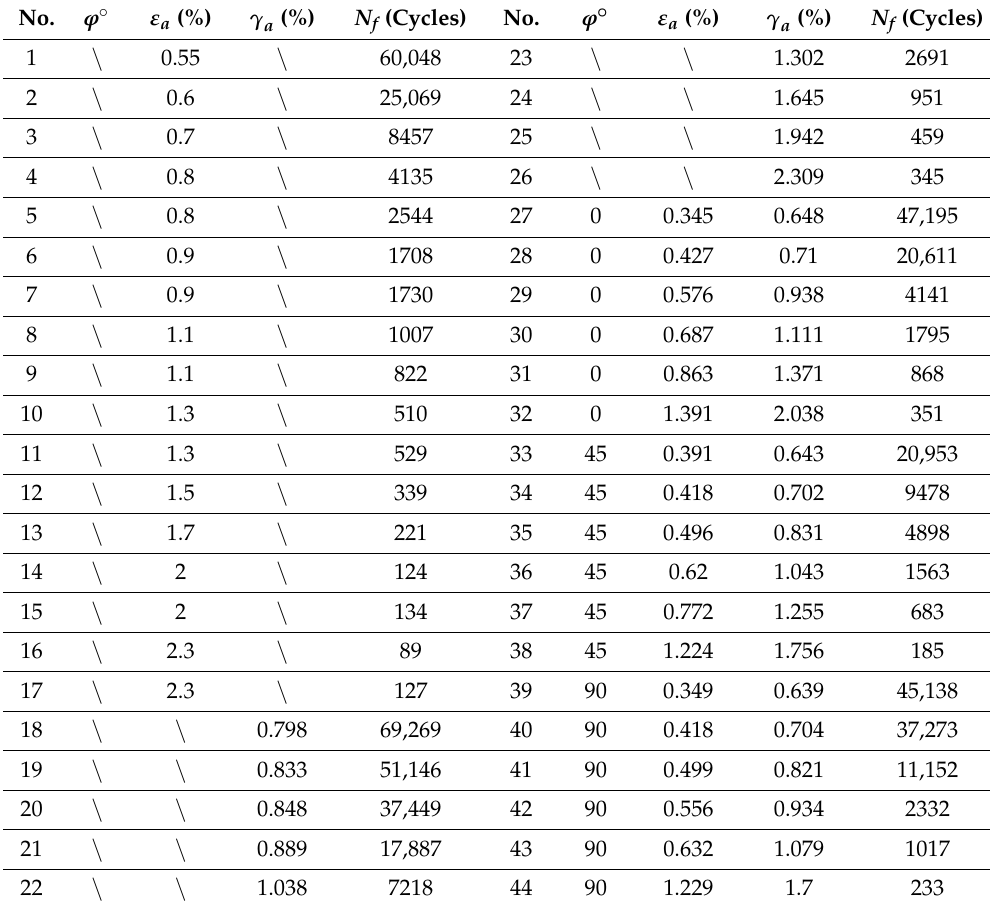
Table 3. Fatigue test data of TC4 for symmetric loadings.